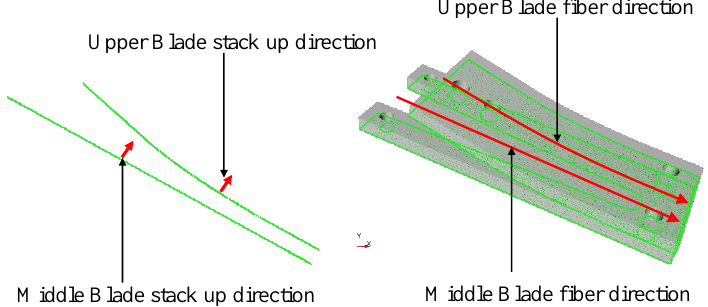
Figure 14. Modeling of the composite parts. The lower blade was considered to be isotropic with elastic properties close to Össur Pro-Flex Pivot’s sole